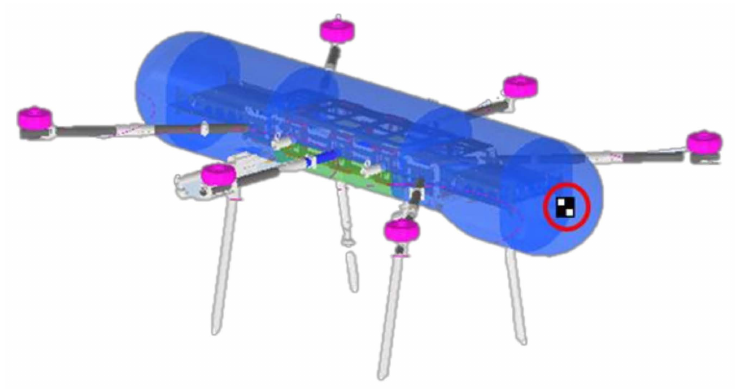
Figure 1. Aerial electric vehicle’s (AEV) marker and position.